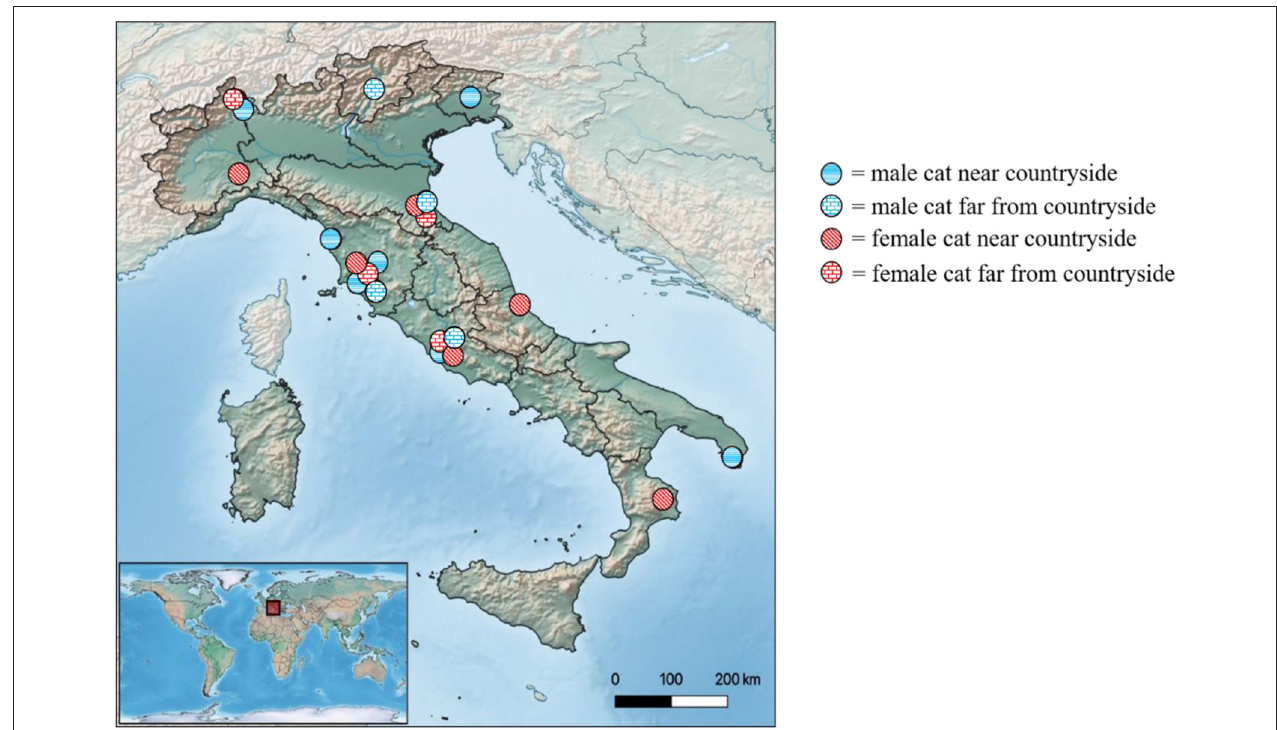
FIGURE 1 | Locations of 21 cat owners who monitored the prey their cats returned over the course of 1 year (January–December 2016).